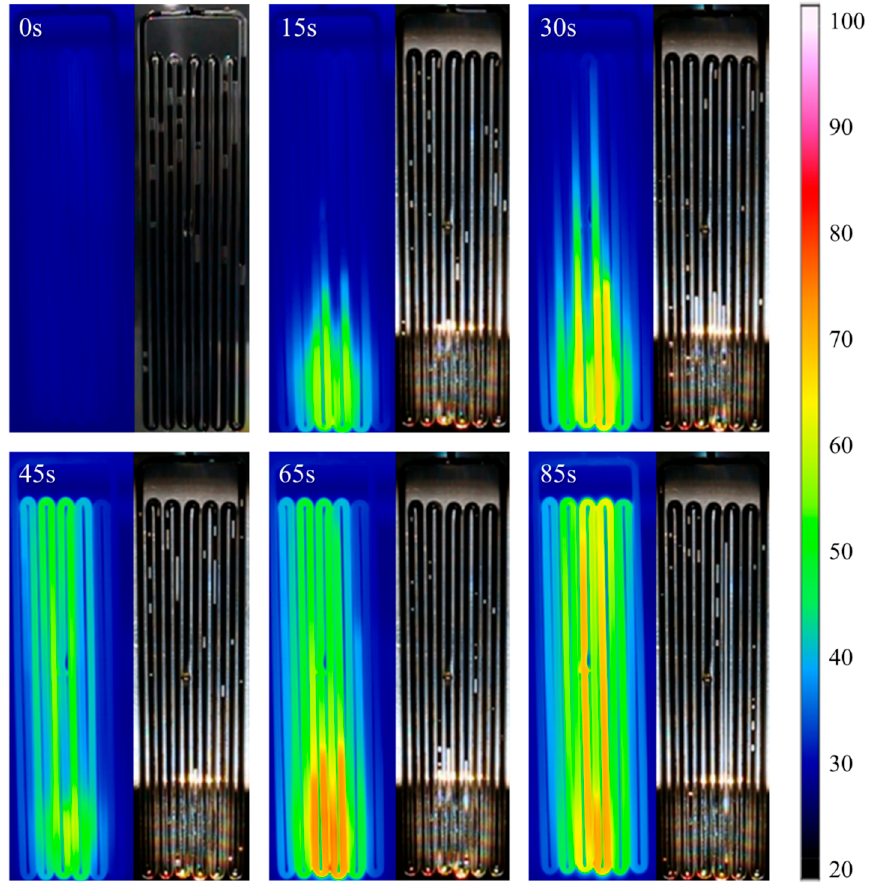
Figure 9. Infrared images and photos from a high-speed camera of the PHP filled with 0.5 wt% MWCNTs nanofluid with a filling ratio of 80%.